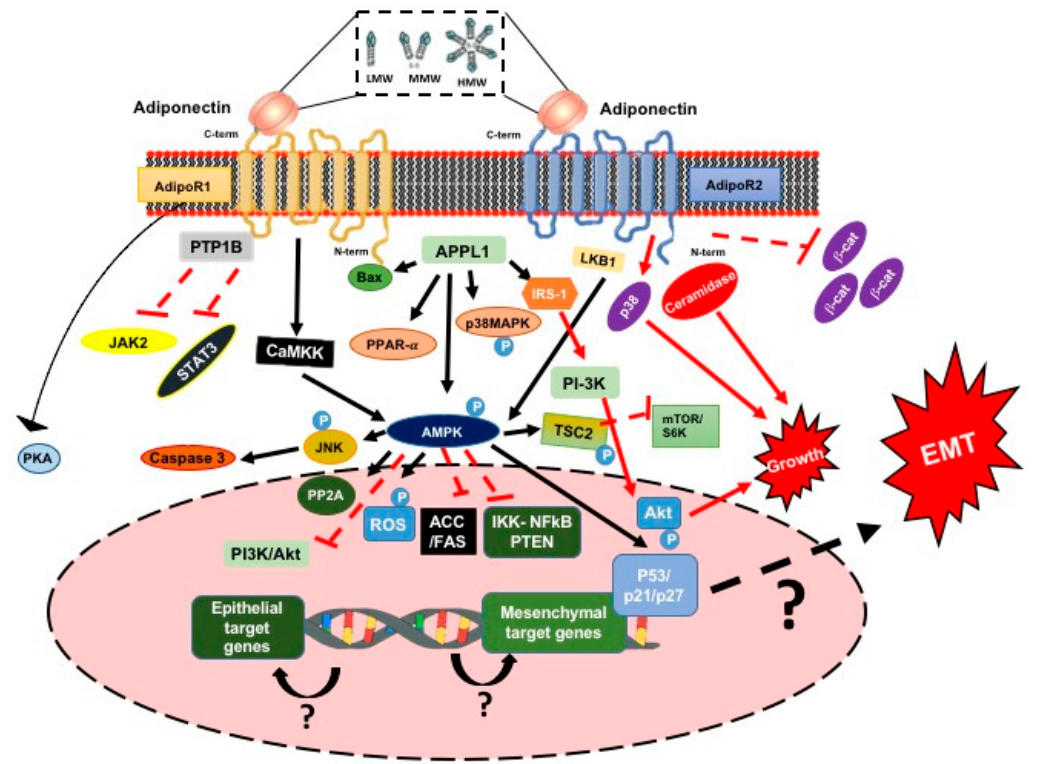
Figure 4. Schematic representation of adiponectin-induced signaling pathway. Adiponectin interacts with its respective receptors, AdipoR1 and AdipoR2, in order to activate a cascade of signaling events. Further studies are needed in order to clarify the possible activation of EMT processes induced by adiponectin.